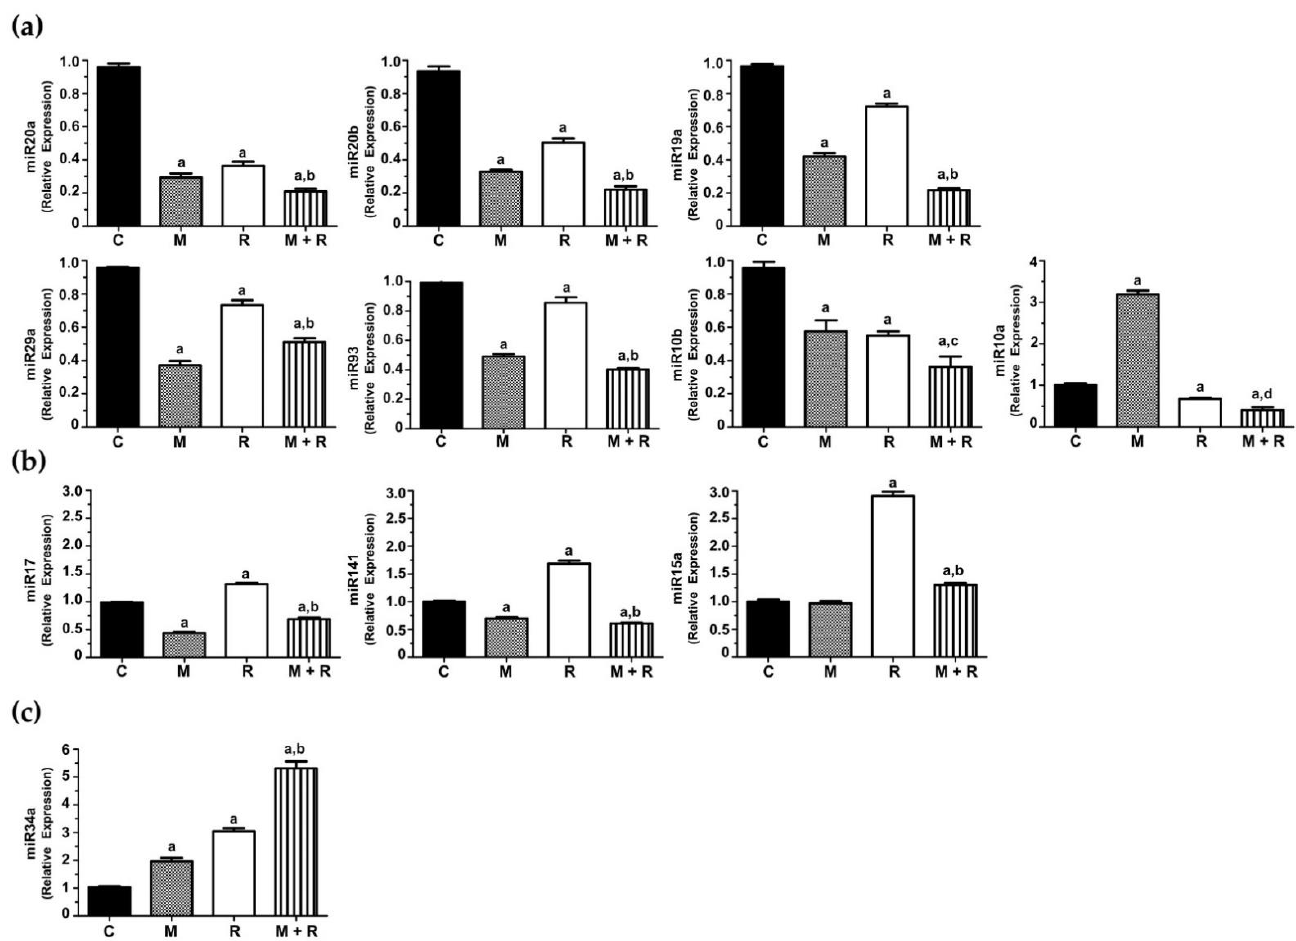
Figure 5. Changes in miRNA expression levels in MCF-7 cells. Cells were pre-treated with 1 nM melatonin for 1 week prior to being irradiated (8 Gy), and after 4 h total RNA was isolated and reverse transcribed; ( a ) RT-PCR analysis of selected miRNAs (miR-20a, miR-19a, miR-93, miR-20b, miR-29a, miR10a and miR10b) where the pre-treatment with melatonin potentiated the inhibitory effect of radiation; ( b ) RT-PCR analysis of selected miRNAs (miR-17, miR-141 and miR-15a) induced by radiation and counteracted by melatonin pre-treatment; ( c ) RT-PCR analysis of miR34a stimulated by radiation and melatonin. Data are expressed as relative normalized expression compared to control cells (mean ± S.E.M.). a, p ≤ 0.001 vs. C; b, p ≤ 0.001 vs. R; c, p ≤ 0.05 vs. R; d, p ≤ 0.01 vs. R.